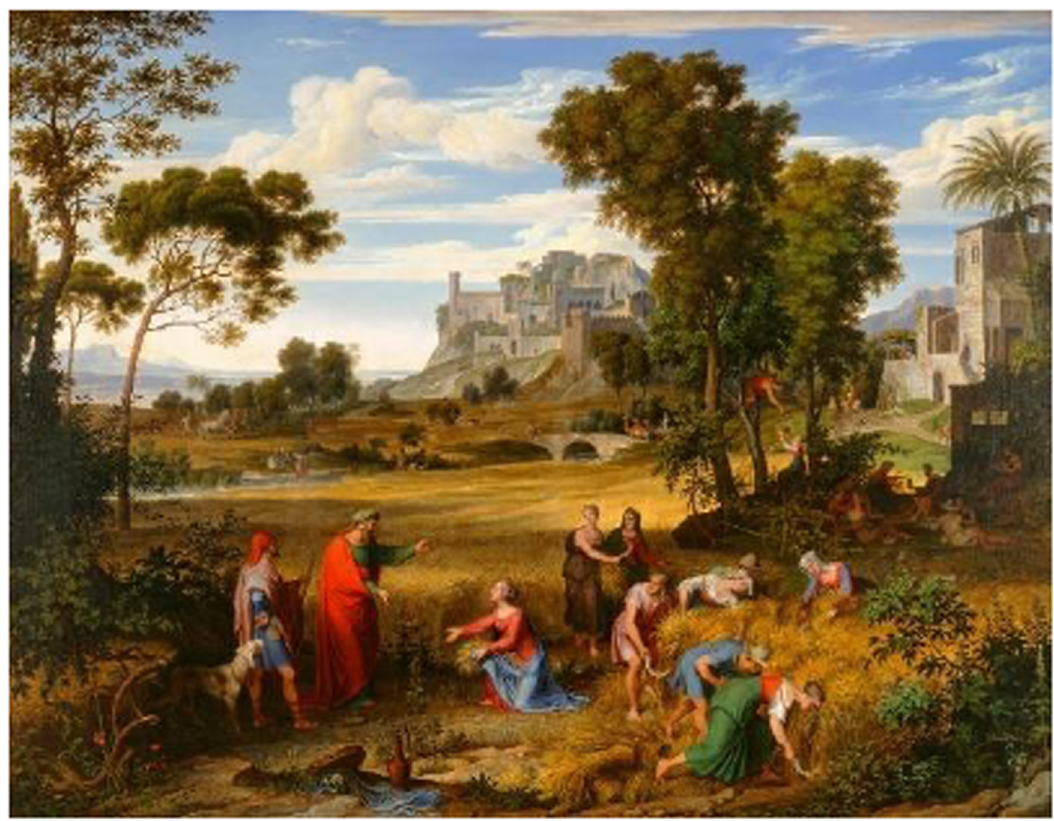
Figure 3: Joseph Anton Koch, Landscape with Ruth and Boaz ,